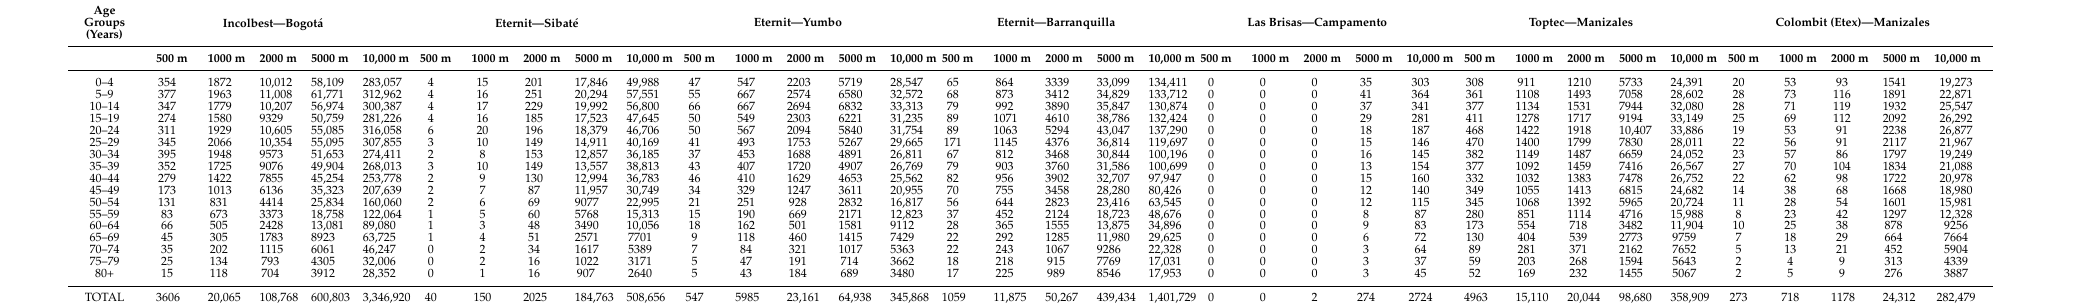
Table 3. Number of people living around the seven main asbestos processing/mining sites in